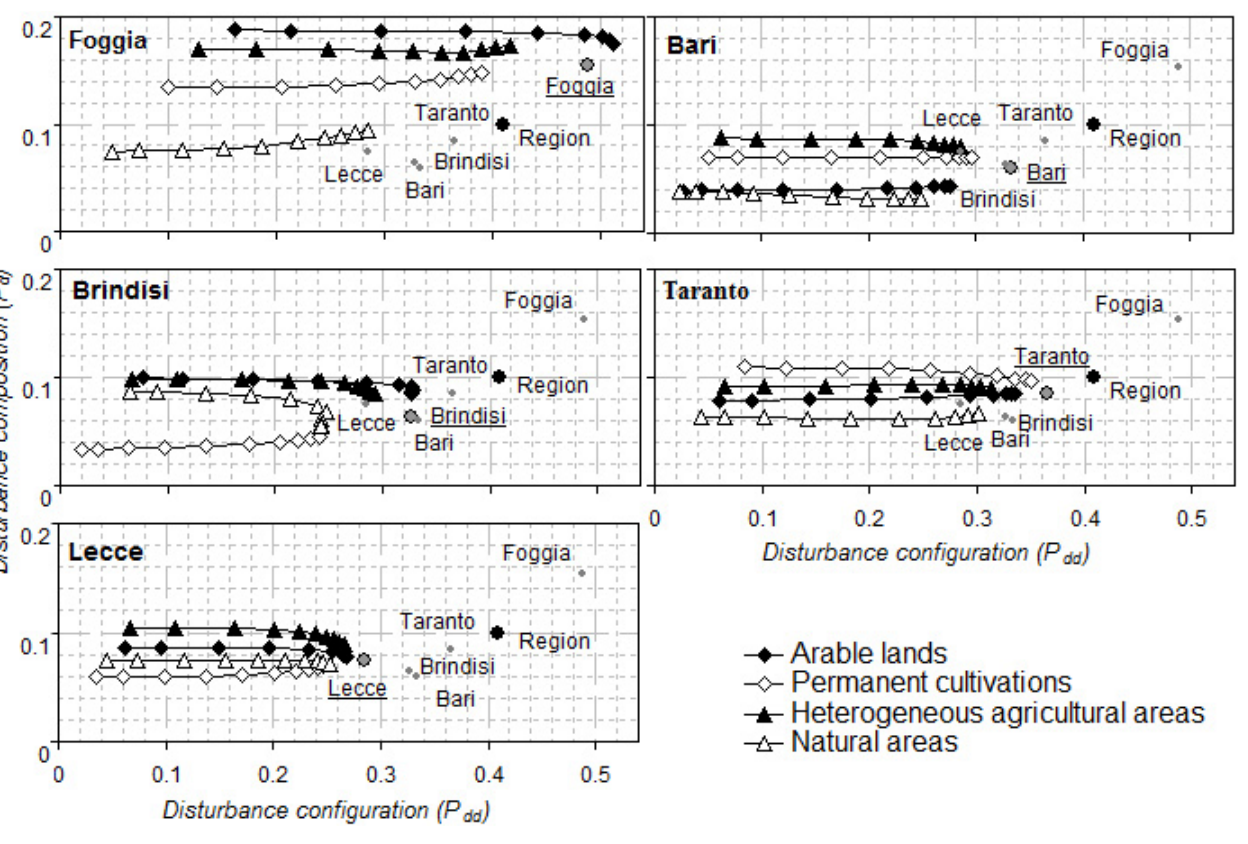
Fig. 4. Land-use disturbance trajectories at multiple scales (10 window sizes) for the five provinces of Apulia at regional P = 0.10, and relative convergence points (CPs) are shown in the same state space d [P , P ] of Fig. 2, and 3. The CP (black dot) for the entire Apulia region is shown for comparison (see d dd